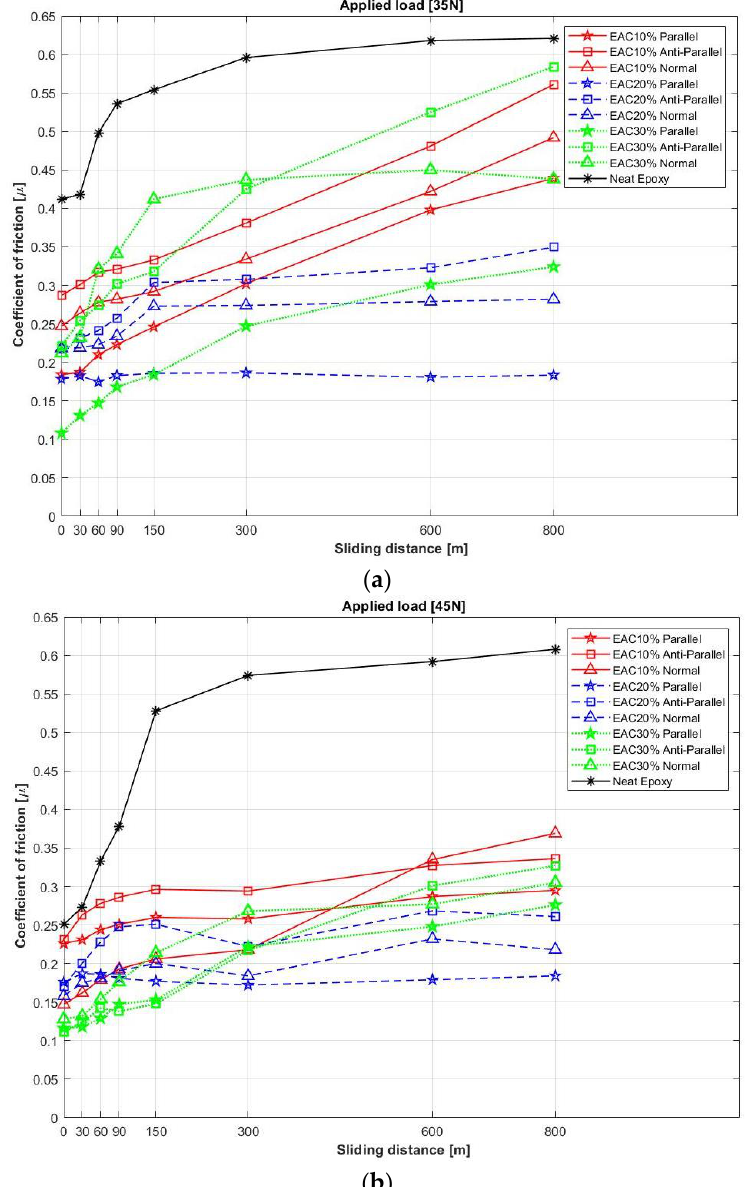
Figure 5. C oefficient of friction of EACs and neat epoxy per sliding distance: ( a ) 35 N applied load and ( b ) 45 N applied